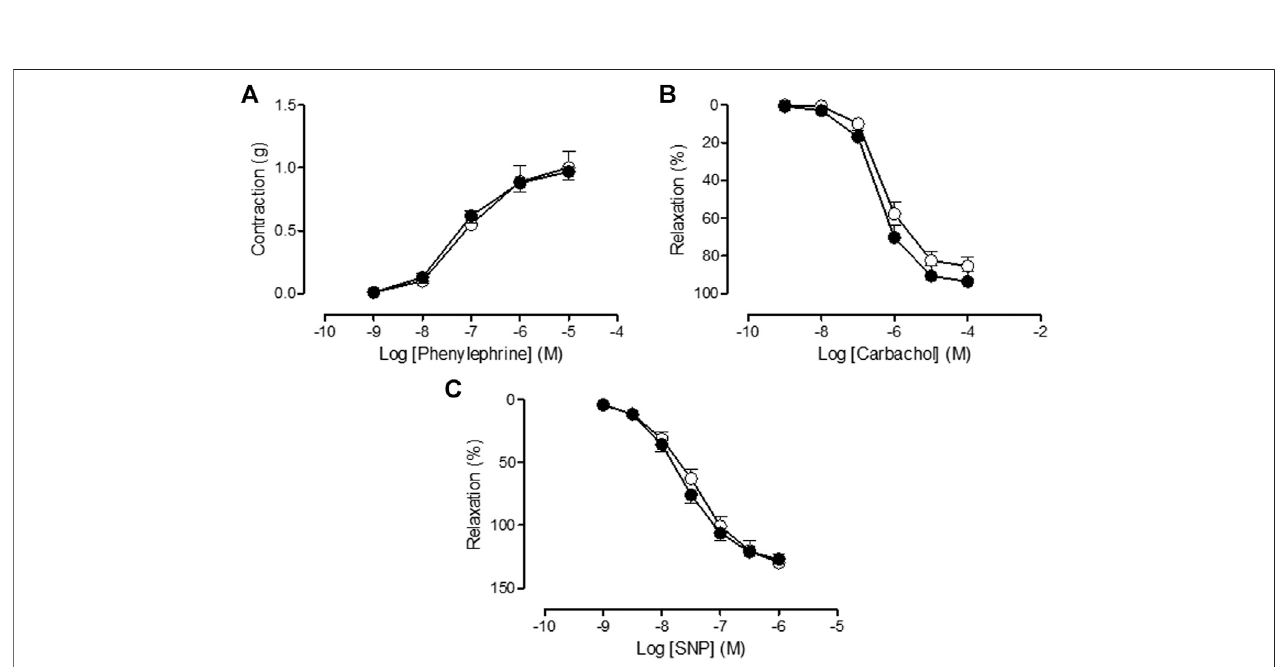
FIGURE 4 | (A) Concentration-response curve of phenylephrine (10 − 9 M – 10 − 5 M), (B) concentration-response curve of carbachol (10 − 9 M – 10 − 4 M), and (C) concentration-response curve of sodium nitroprusside (SNP) (10 − 9 M – 10 − 6 M) in isolated rat aorta rings from animals two weeks post-treatment with saline (sequelae saline, white circles) or vincristine (sequelae vincristine, black circles). Values are expressed as mean ± SEM, n (cid:2) 9 – 12 preparations per experimental group. A two-way ANOVA followed by the Bonferroni test was used for statistical